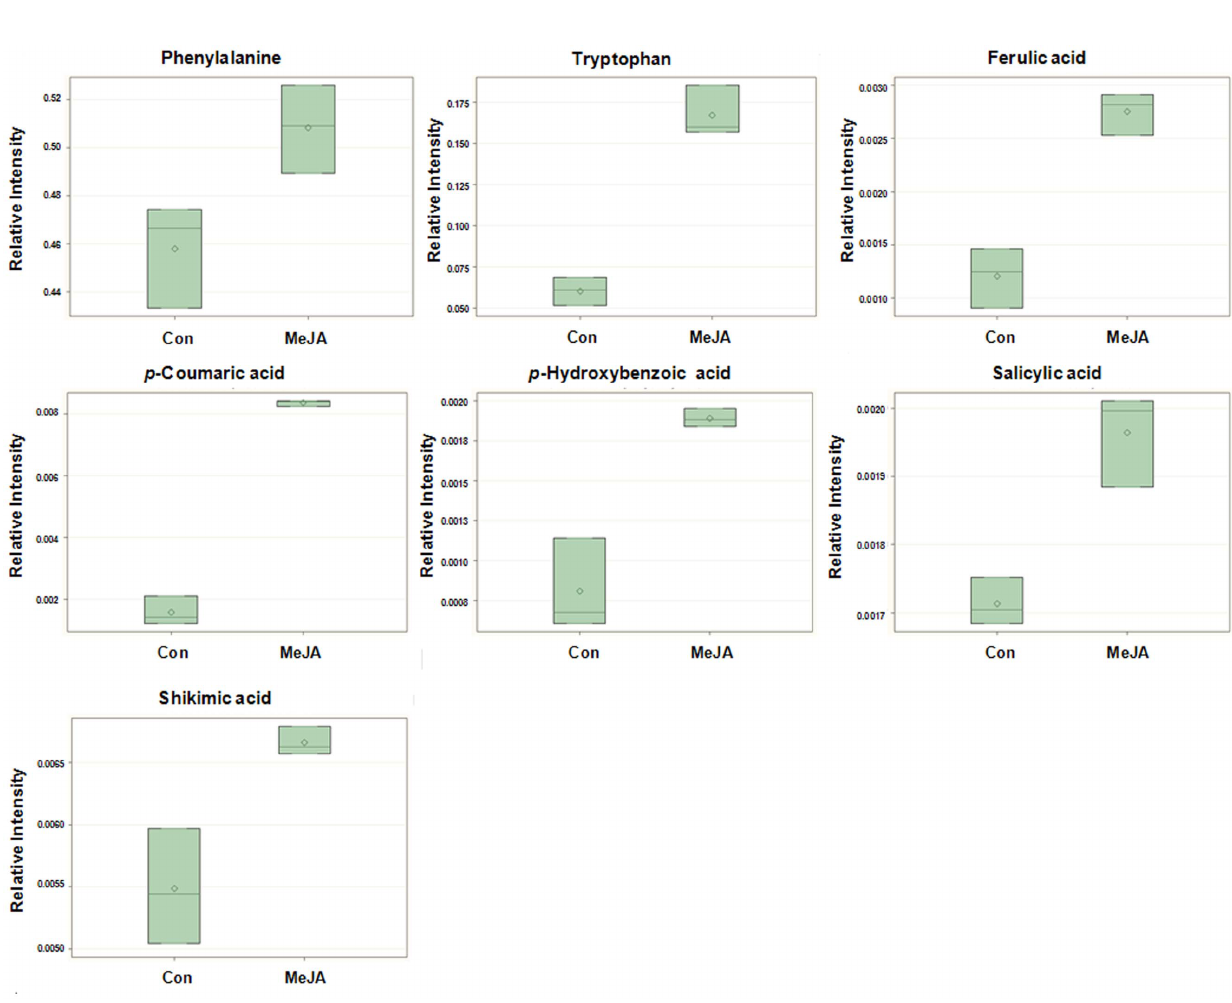
Figure 6. Box plots of aromatic amino acids, phenolic acids, and shikimic acid that were significantly different between the MeJA- treated A.rugosa cells and control